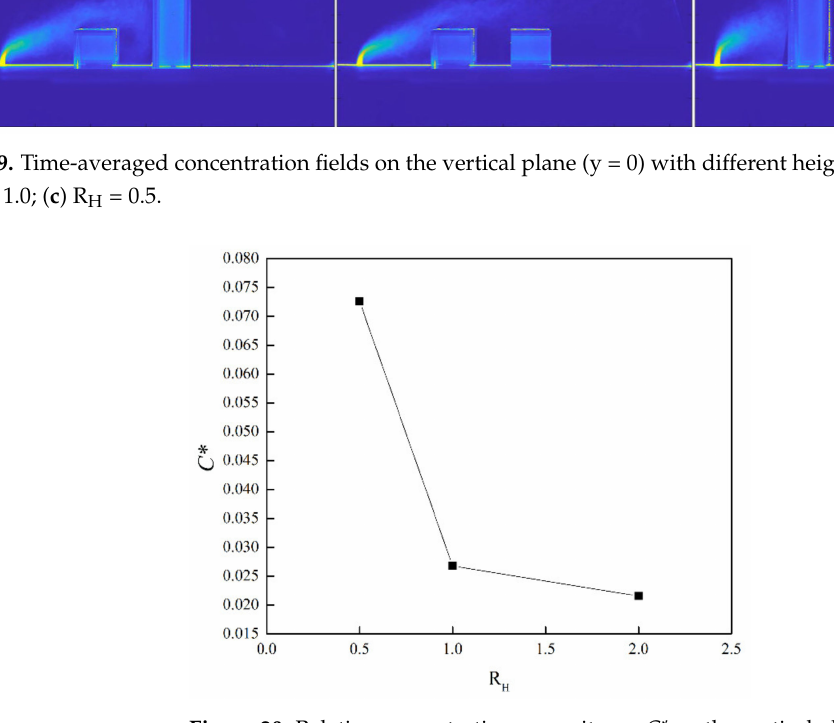
Figure 20. Relative concentration per unit area C* on the vertical plane (y = 0) of streets with different height